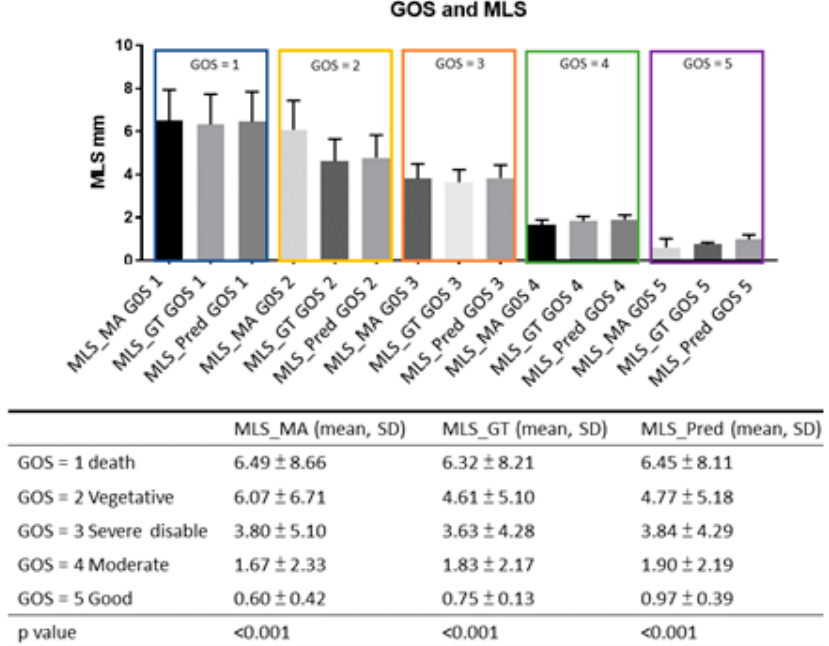
with various initial GCSs ( A ) and GCS on day 7 ( B ). The MLS_MA indicates that the MLS was manually measured. MLS_GT represents the MLS measured by the calculation from the automated defined keypoints. MLS_pred is the MLS measurement generated by using the automated detection method. GCS 3–8 (orange), 9–12 (green), and 13–15 (purple) indicates the degree of coma scale in different patients. The MLS was inversely correlated to the coma scale score.